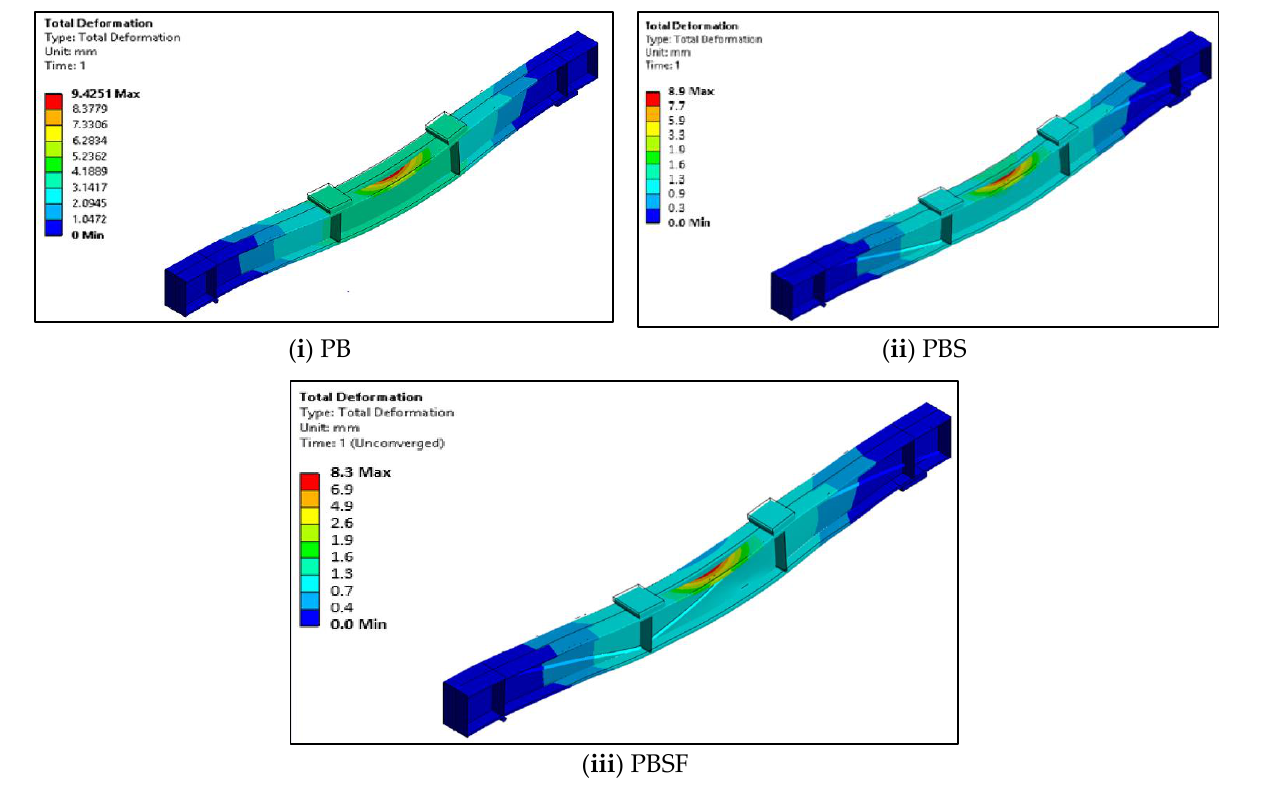
Figure 20. Deflected shapes of the plain CFS beams.